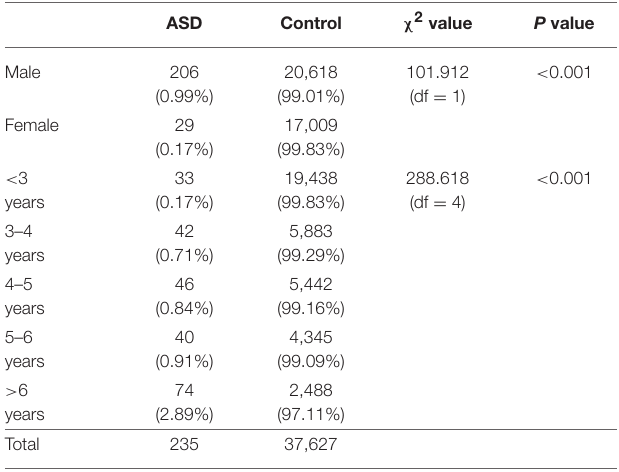
TABLE 3 | Potential impacts of genders and ages on ASD